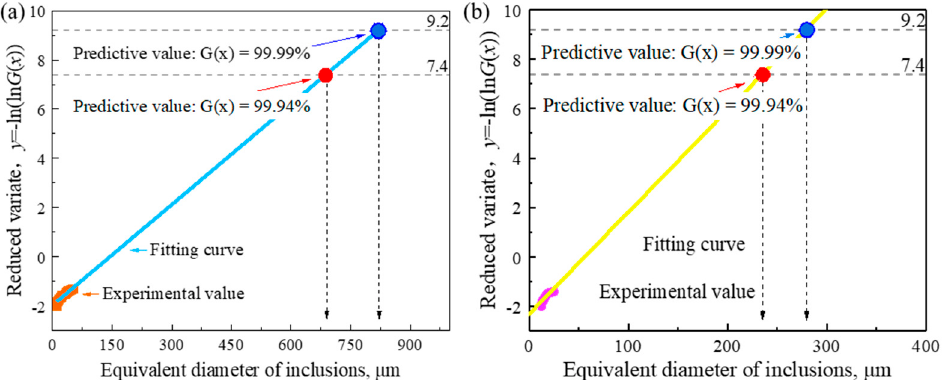
Figure 14. The maximum size of oxide inclusions ( a ) and sulfide inclusions ( b ) inferred by the LEVD method.